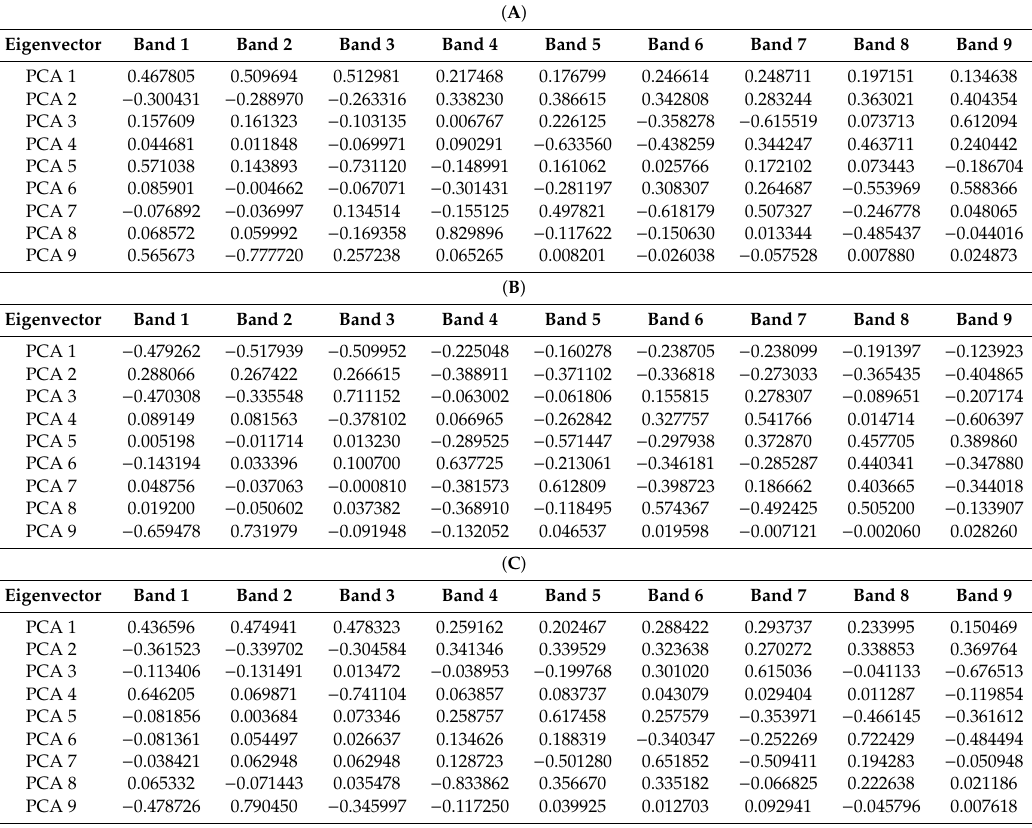
Table A1. Eigenvector matrix for VNIR + SWIR bands of ASTER. ( A ): Spatial subset covering zone 1 and surrounding areas; ( B ): Spatial subset covering zones 2 and 3; ( C ): Spatial subset covering zone 4 and surrounding areas; and ( D ): Spatial subset covering zones 5 and